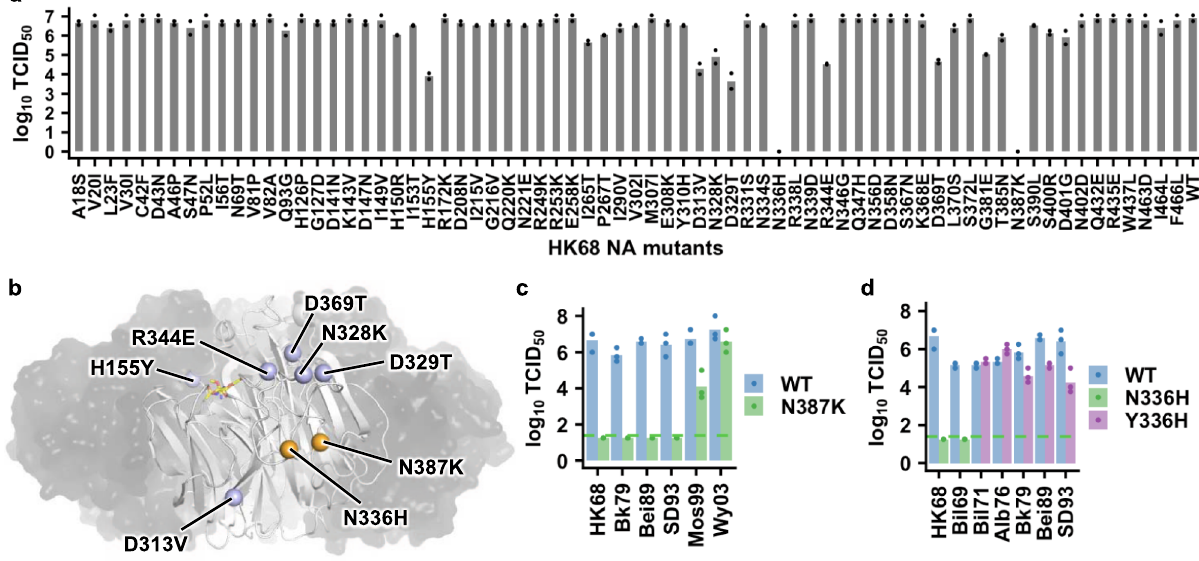
Fig. 1 | Virus rescue experiments of natural mutations. a The amino acid sequencesofHK68NAandVic11NAdifferedby70aminoacidsubstitutions.These 70 mutations were individually introduced into HK68 NA. Their replication fi tness was examined by a virus rescue experiment. Virus titer was measured by 50% cell cultureinfectiousdose(TCID 50 ).Eachbarrepresentsthemeanoftwoindependent biological replicates. Each datapoint represents one biological replicate. b The locationsofthe eightmutationsthatshowed atleasttwo-logdecrease invirustiter comparedtothewildtype(WT)areshownasspheresononeprotomerofNAthatis in white cartoon representation, while the other three protomers are shown as semitransparent blacksurface (PDB3TIA) 21 . Sialic acid in the active site is shown as